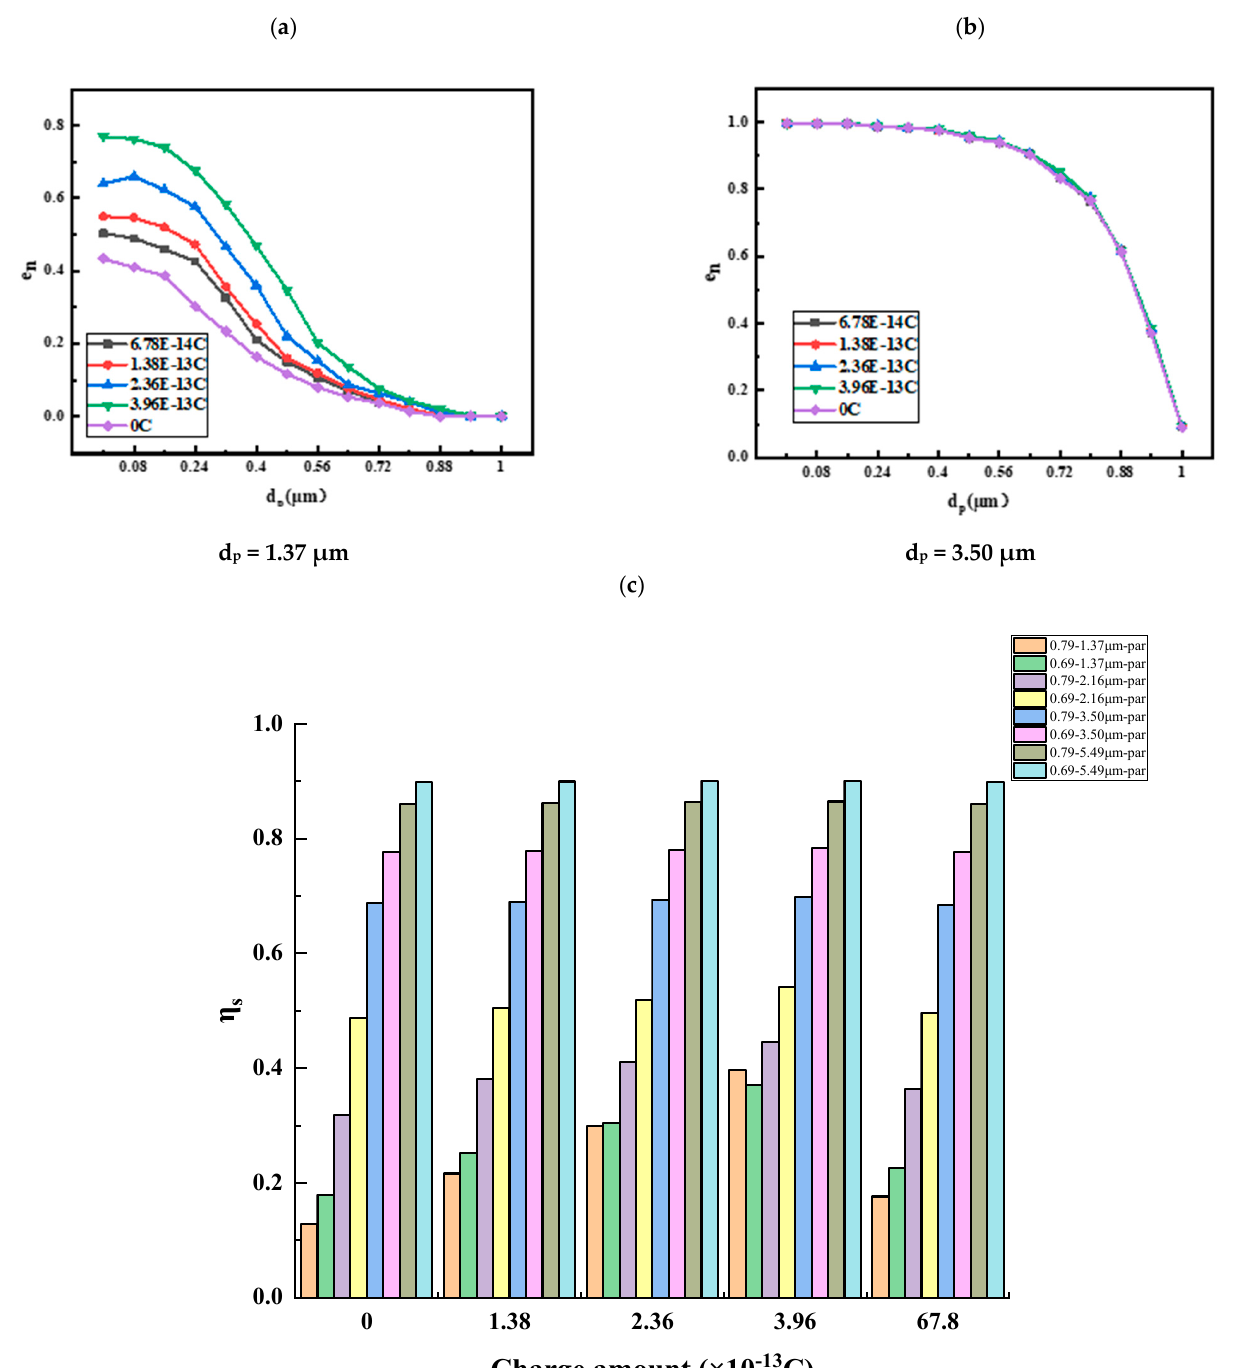
Figure 8. Trapping efficiency for different droplet charges.(( a ) micron particles ( b ) micron particles ( c ) submicron particles)